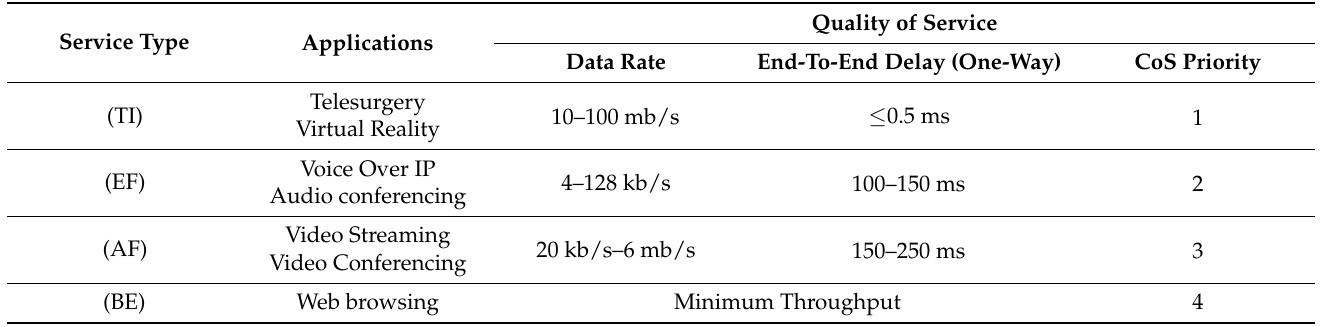
Table 3. QoS Requirements and class of service (CoS) Mapping in